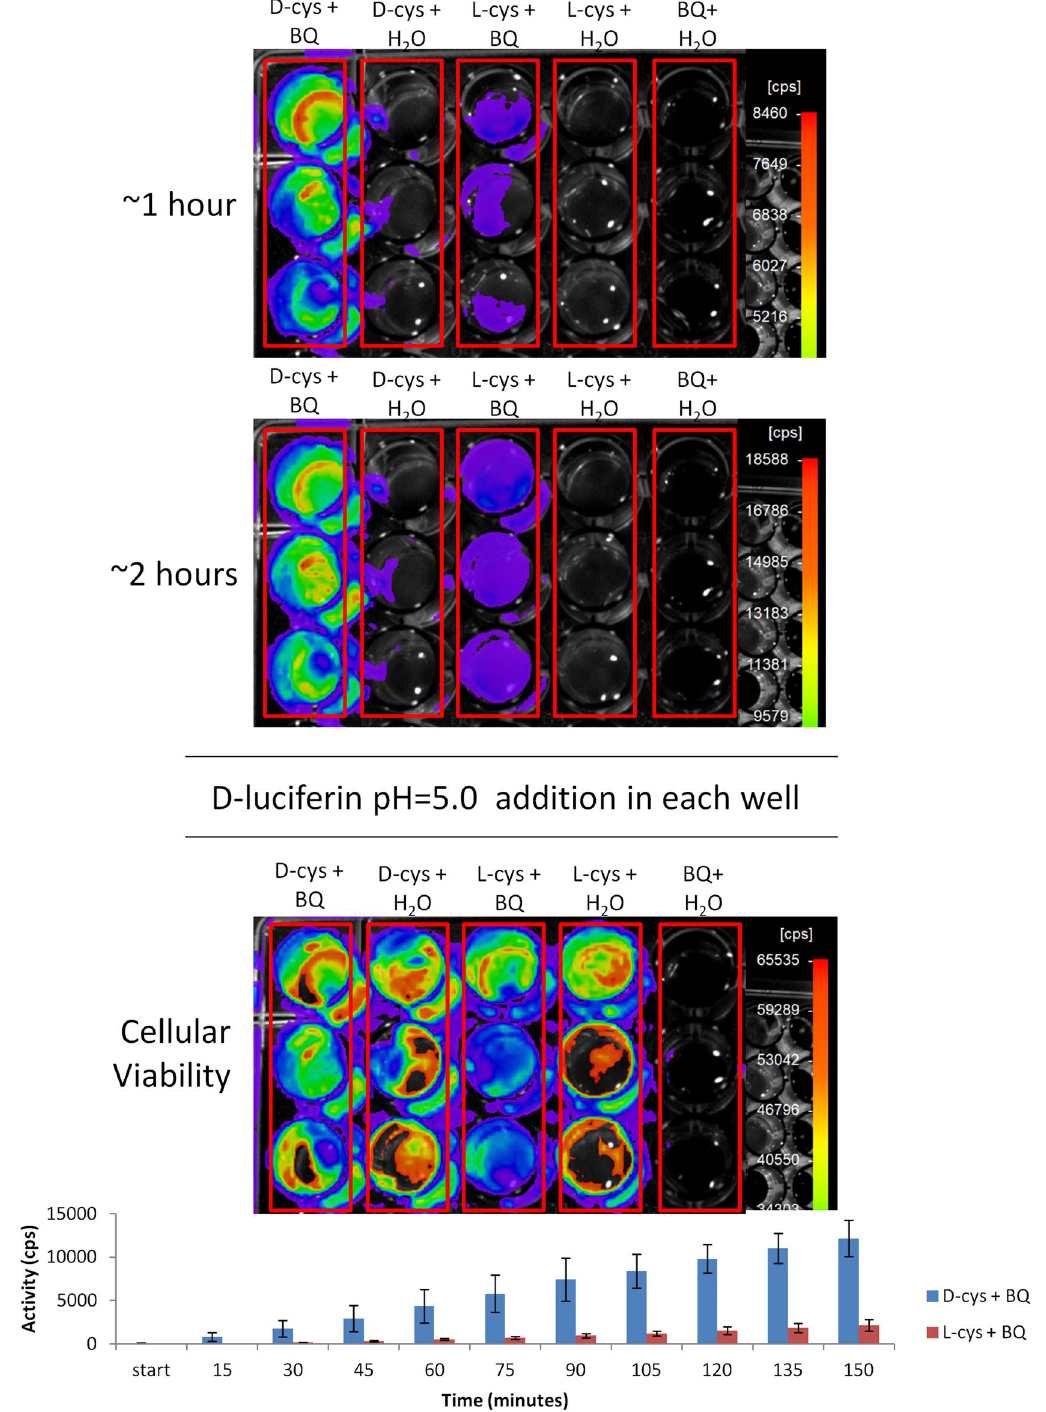
Figure 4. Bioluminescence of E. coli BL21 transformed with Amydetes vivianii firefly luciferase to sense luciferin formation from cysteine and p -benzoquinone. The cellular viability was analyzed by addition of 10 µL of 1 mM d-luciferin pH 5.0 in each well, at the end of the assay of luciferin formation. Bars graph shows the bioluminescent activity over